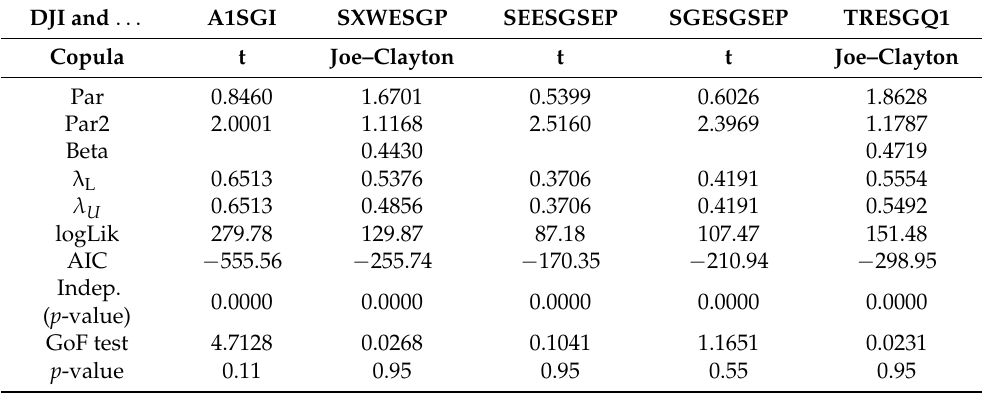
Table 3. Dependence structure for DJI and ESG indices, 3 July 2007–30 January 2009. DJI and . . .